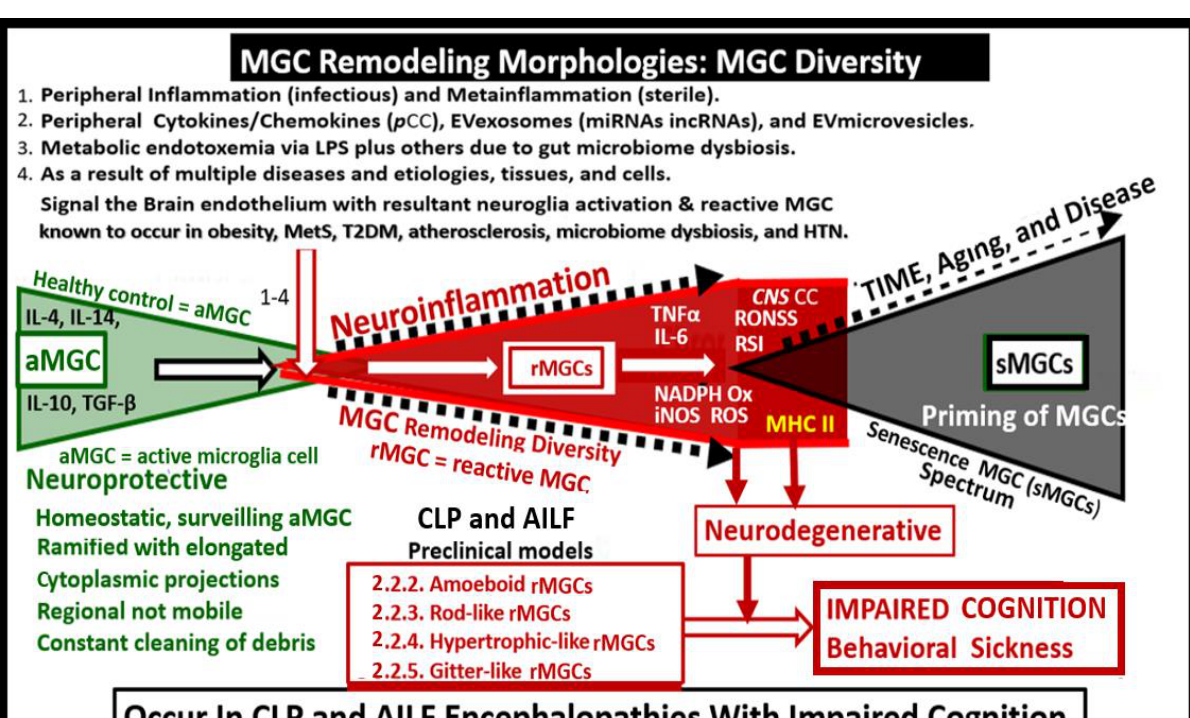
Figure 8. Peripheral inflammation signaling of the brain via the neurovascular unit (NVU) and circumventricular organ brain endothelial cell(s) (BECs) resulting in multiple reactive microglia cell(s) (rMGCs) remodeling morphologies with diversity in the cecal ligation and puncture (CLP) and the acetaminophen injury liver failure (AILF) models to induce neuroglia activation. This illustration depicts that the active MGCs (aMGCs) are constantly cleaning the accumulation of the normal debris that is present in the healthy brain. These aMGCs phenotypes are capable of undergoing a diverse spectrum of remodeling morphologies and inflammatory phenotypes to the various rMGCs depicted in the CLP and AILF preclinical models and previously presented in sections (S) in Section 2.2.2. (amoeboid arMGCs); Section 2.2.3. (rod-like arMGCs); Section 2.2.4. (hypertrophic-like arMGCs); Section 2.2.5. (gitter-like rMGCs). Additionally, with aging and disease, microglia become more highly primed as a result of their morphological remodeling and inflammatory phenotypes to the senescent spectrum morphologies. HTN = hypertension; IL = interleukin; iNOS = inducible nitric oxide synthase; MetS = metabolic syndrome; NADPH Ox = reduced nicotinamide adenine dinucleotide phosphate oxidase; ROS = reactive oxygen species; RONSS = reactive oxygen, nitrogen, sulfur species; RSI = reactive species interactome; T2DM = type 2 diabetes mellitus; TGF- β = transforming growth factor-beta; TNF α = tumor necrosis factor